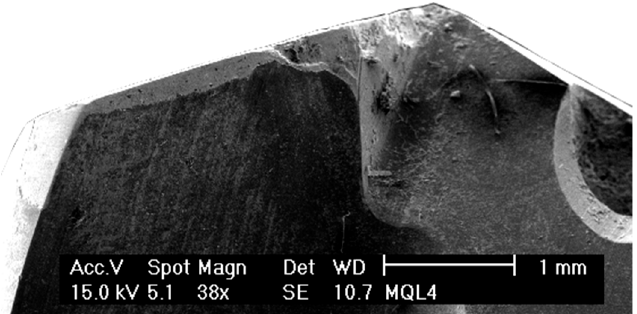
Figure 4. Wear of the tool tested on a Ti/CFRP/Ti stack with the higher lubrication level (15 mL/h), after 40 holes.